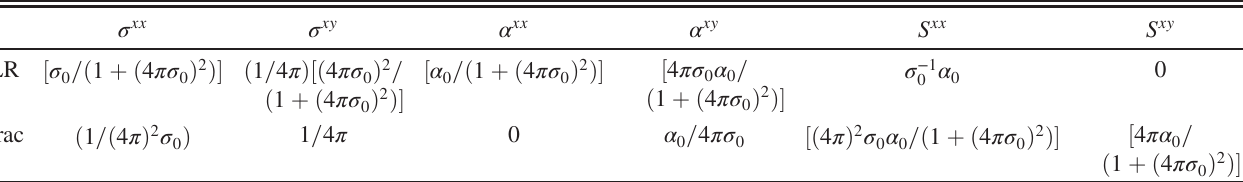
TABLE I. Summary of thermoelectric coefficients for the HLR and Dirac states. We have used units where e ¼ 1 and ℏ ¼ 1 , so the quantum of resistance h=e 2 ¼ 2 π . See Eq. (5) for the definition of σ 0 , α 0